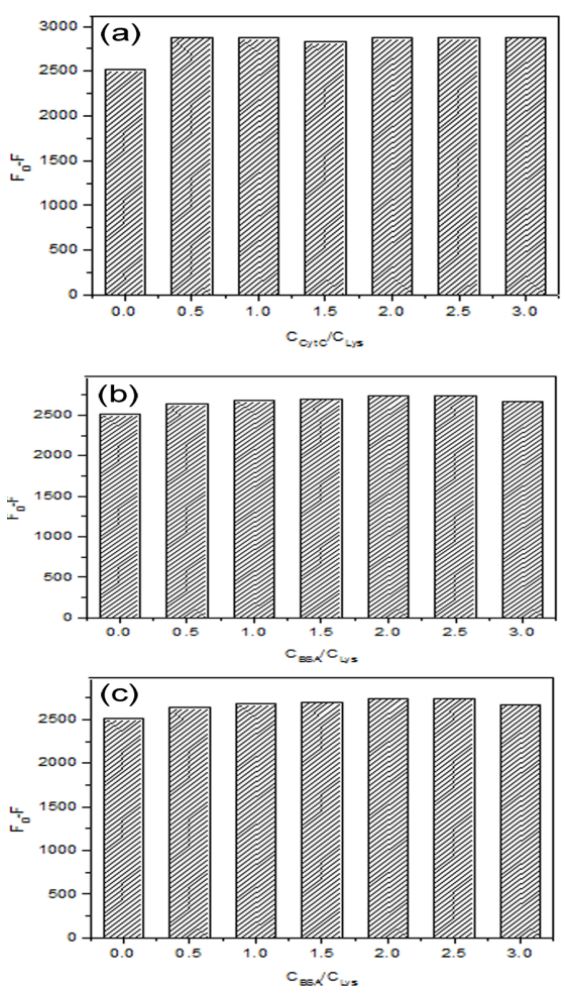
Figure 6. Influence of the competitive proteins Cyt (C /C 0, 0.5, 1.0, 1.5, 2.0, 2.5, 3.0) ( b ); and BSA (C Hb (C Cyt C Lys